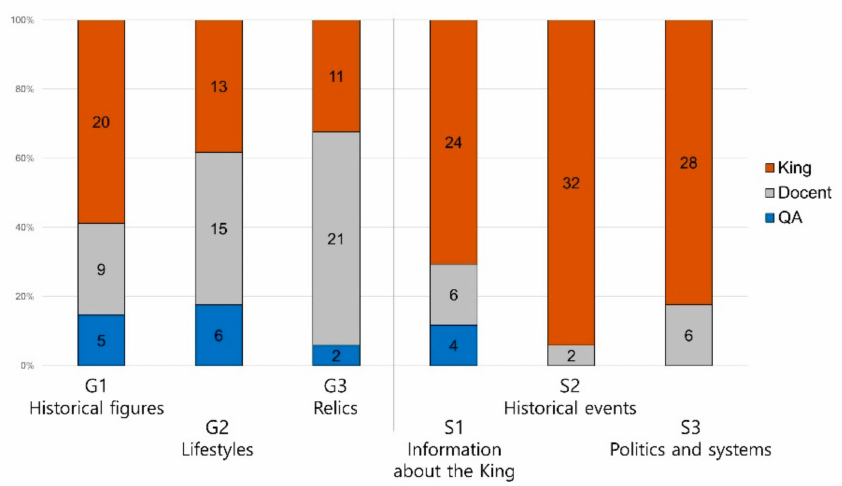
Figure 7. Model preference on